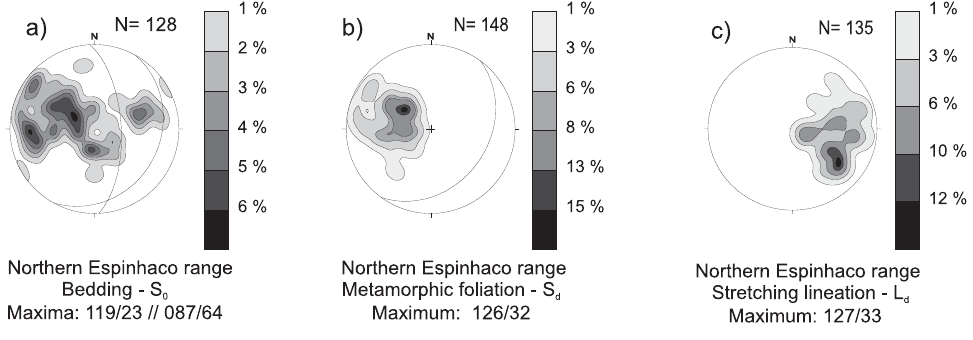
Fig. 9 – Equal-area, lower hemisphere stereonet plots of poles to foliations and lineations observed in the São Francisco basin and northern Espinhaço range, structural domain